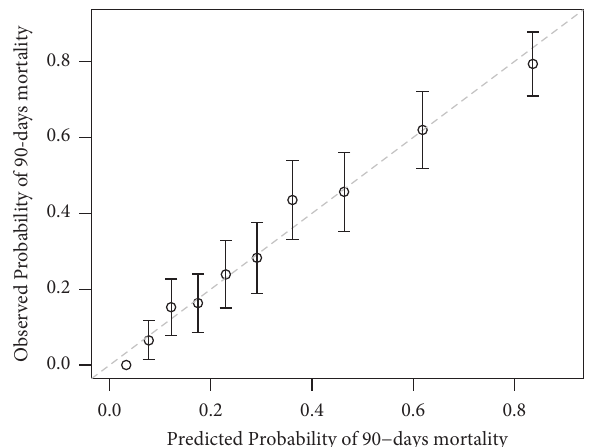
Figure 3: Calibration plot of the combined “SOFA +MACA” model to predict short-term mortality. Regarding the Hosmer and Lemeshow test, this combined “SOFA+MACA” model exhibited a good calibration ( p � 0 . 47). MACA, metabolic failure, age, and comorbidity assessment; SOFA, sequential organ failure